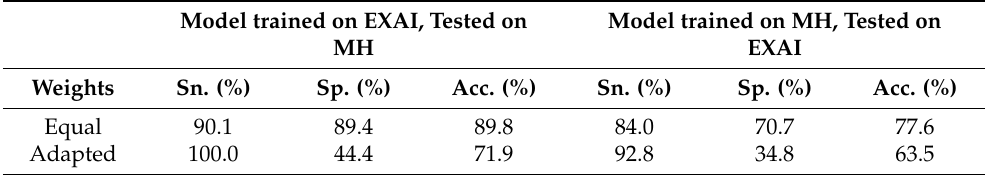
Table 8. Results of combined models with equal and adapted weights